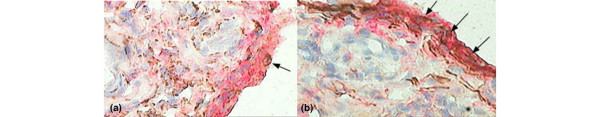
The cellular origins of c19orf10 in the synovium. Sections of rheumatoid arthritis synovial tissue stained with anti-c19orf10 stained red. (a) Sections stained with anti-CD68 to detect macrophage-like cells stained brown (arrow). (b) Sections stained with anti-CD55 to detect fibroblasts stained brown (arrows). There was a clear colocalization with CD55-staining cells, whereas the association with CD63-positive cells was much less apparent. c19orf10, chromosome 19 open reading frame 10.